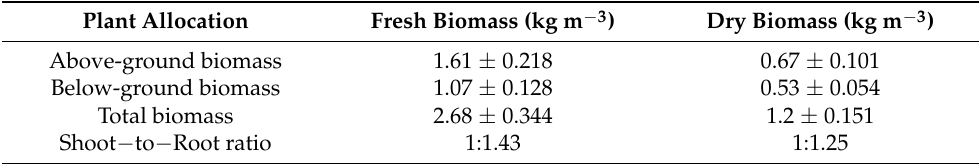
Table 1. Mean and ratio of vetiver dry and fresh biomass (shoot to root) production (kg m − 3 ) plantation in 1.0 m pot in a sand soil for the experimental period (7 month).